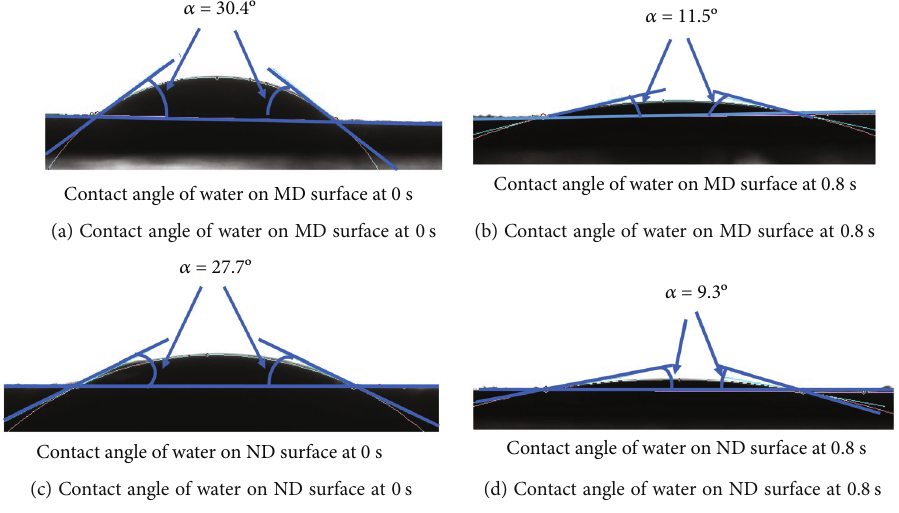
Figure 2: Contact angles of water on the surface of MD and ND at the beginning and the ending of the